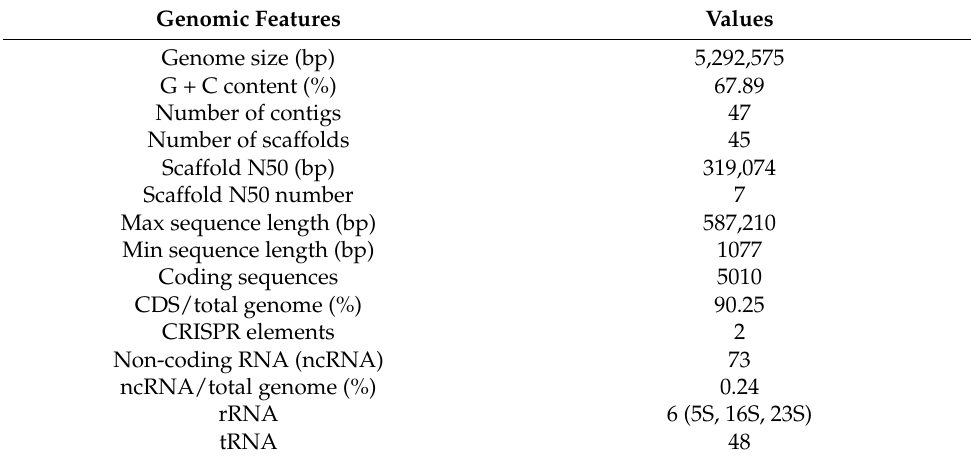
Table 1. Genomic features of Variovorax sp. strain